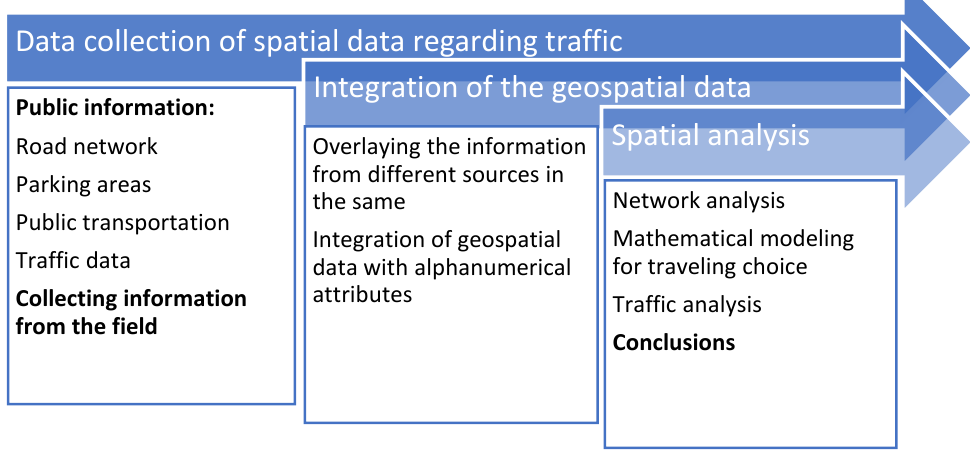
Figure 4. Methodology of the study.